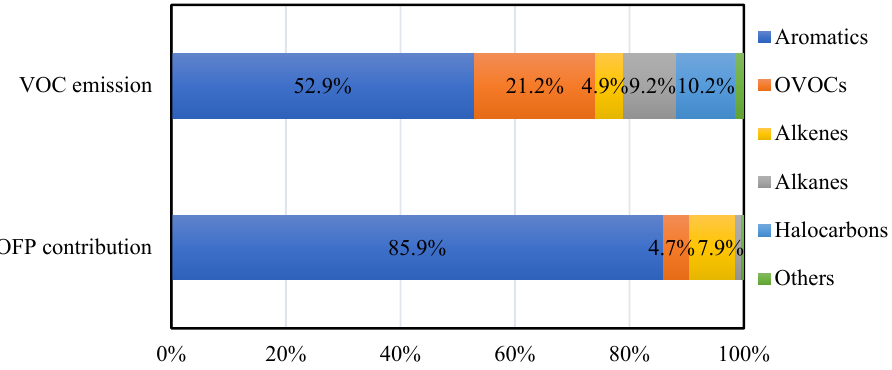
Figure 4. Speciated characteristics of VOCs emissions and OFP of the surface-coating industries in Jiangsu for the year of 2020.